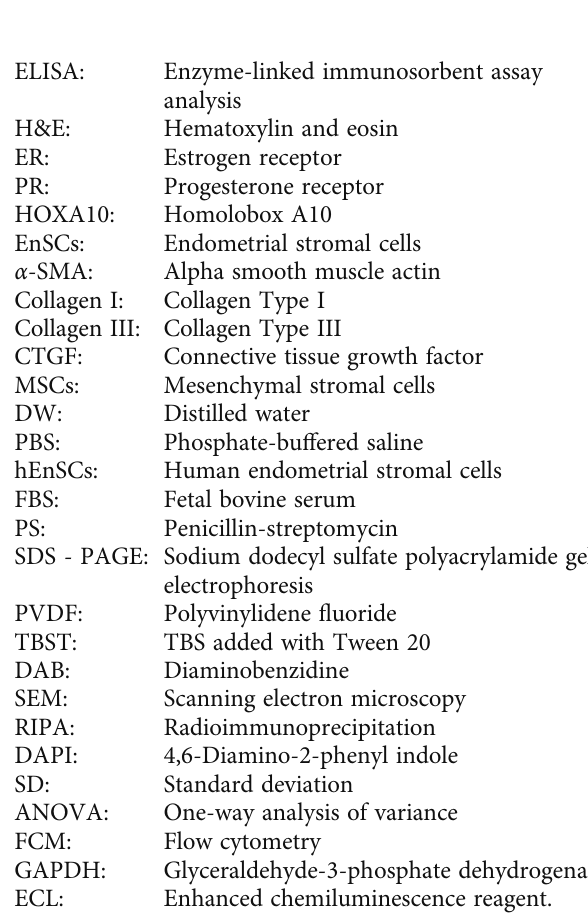
Figure 7: Immuno fl uorescent staining of MMP-9 and TIMP-1 in hEnSCs within each group. (a) MMP-9 and TIMP-1 expressions in hEnSCs within each group were determined using immuno fl uorescent staining (200x). (b – d) Mean fl uorescent intensities were analyzed using ImageJ software. Data are presented as the means ± SDs . ∗ P < 0 : 05, ∗∗ P < 0 : 01, and ∗∗∗ P < 0 : 001 . CDDP: cisplatin; MMP-9: matrix metalloprotein 9; TIMP-1: tissue inhibitor of